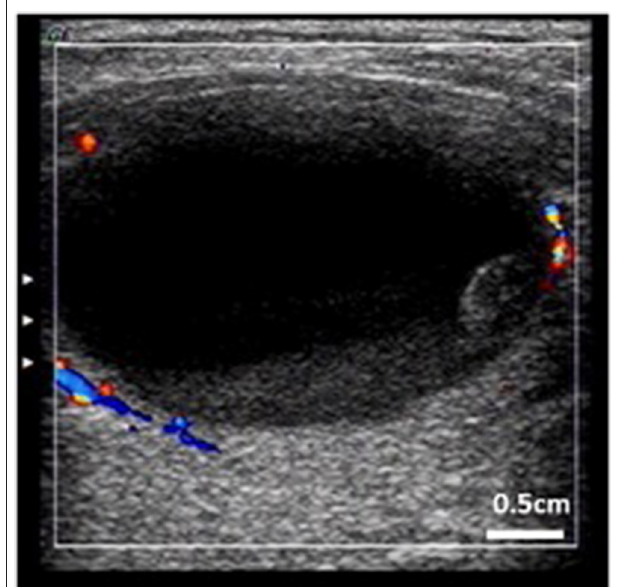
FIGURE 1 | Thyroid cystic nodule prone to intracystic hemorrhage. (Characteristic: bigger, more cystic components, peripheral blood flow, and stale hemorrhage in the nodule).